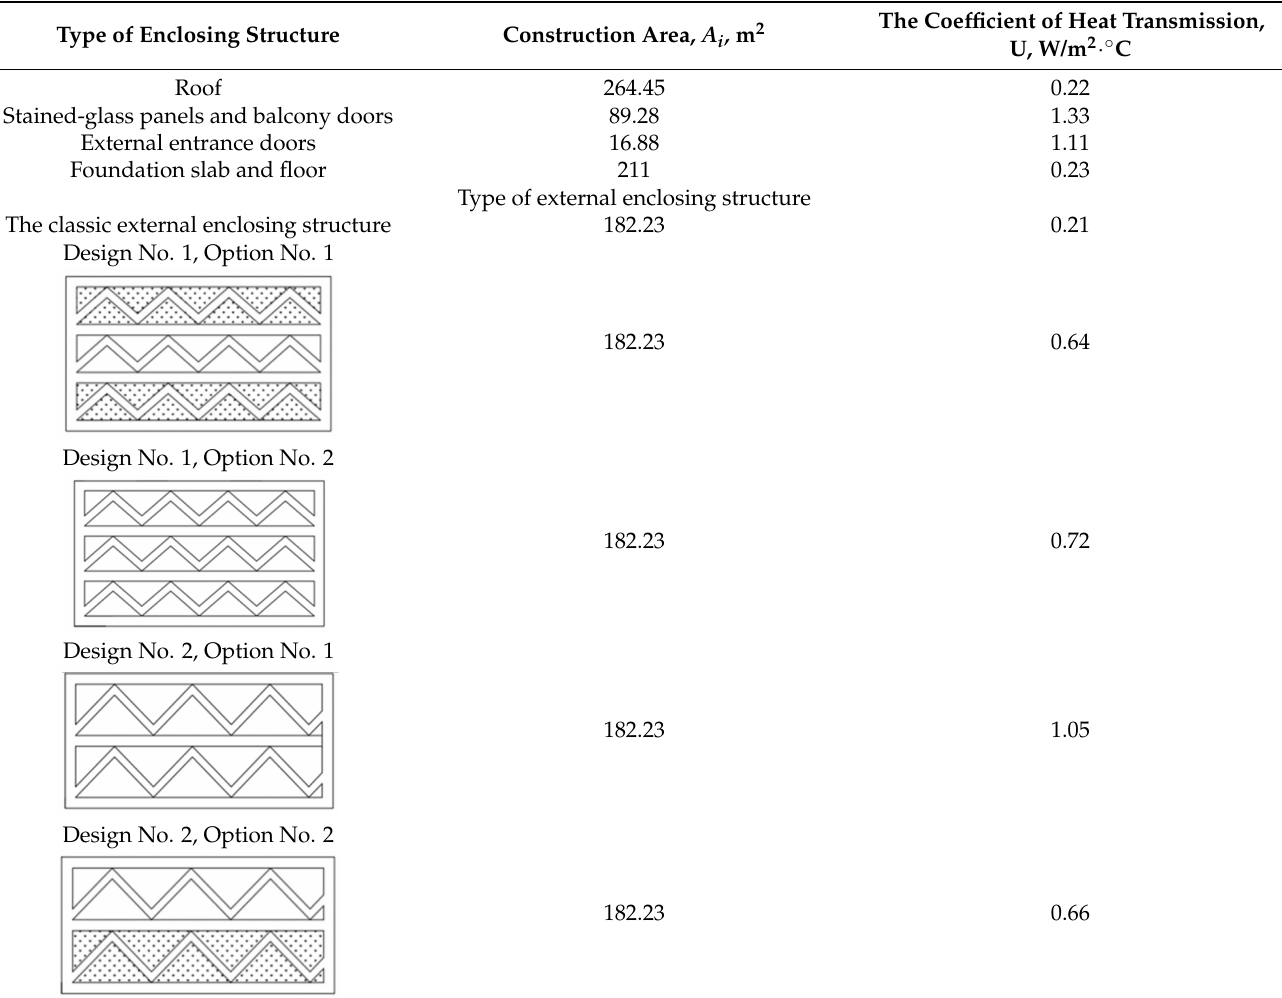
Figure 17. Three-dimensional view of the building. The geometric and technical parameters for the calculation are shown in Table 9. Table 9. Geometric and technical parameters for the